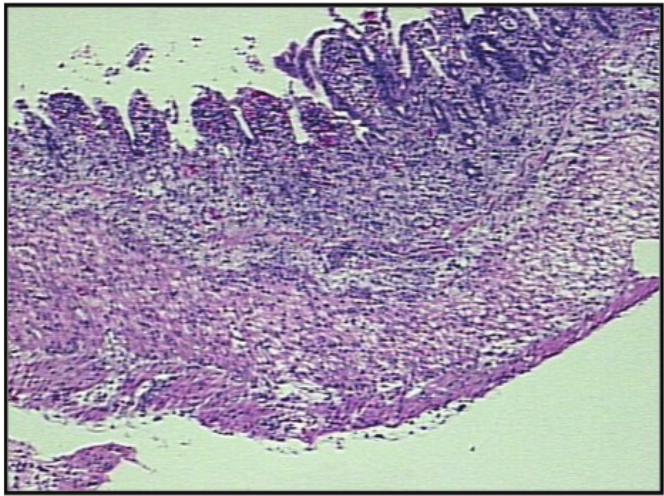
FIGURE 6 - Histological aspect of severe acute cellular rejection in the intestinal graft, with extensive villus blunting and extensive ulceration of villus revetment epithelium. In intestinal mucosa, it was observed destruction of mucosa glands and intense and diffuse inflammatory cell infiltrate in lamina propria. Vasculitis due to inflammatory infiltrate was more prominent in mucosa and submucosa. Edema was observed in submucosa and muscular wall, in addition to apoptotic cells and transmural necrotic focuses (x100